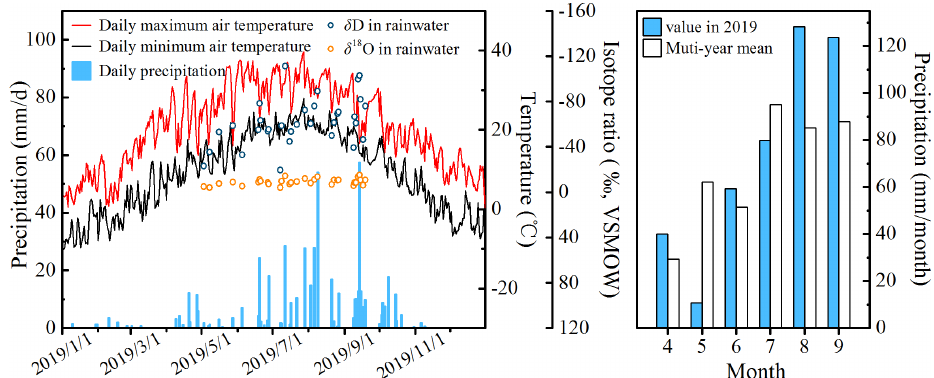
Figure 2. Time series of meteorological data and rain water isotopic values in 2019, monthly precipitation in 2019, and multi-year mean, respectively.